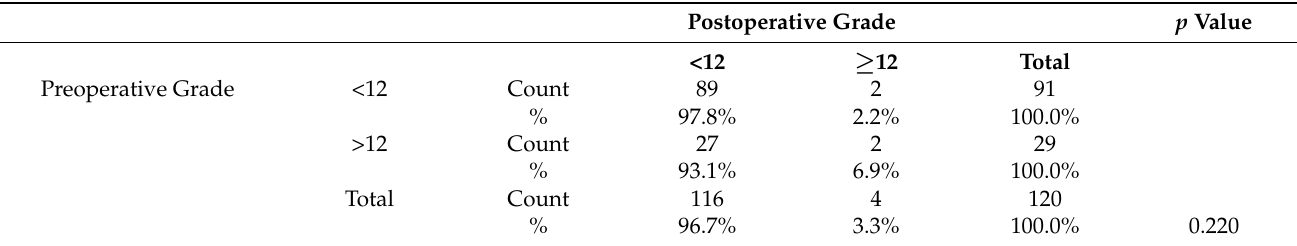
Table 3. Comparison between pre and post operative constipation scores (Agachan–Wexner Consti- pation Scoring